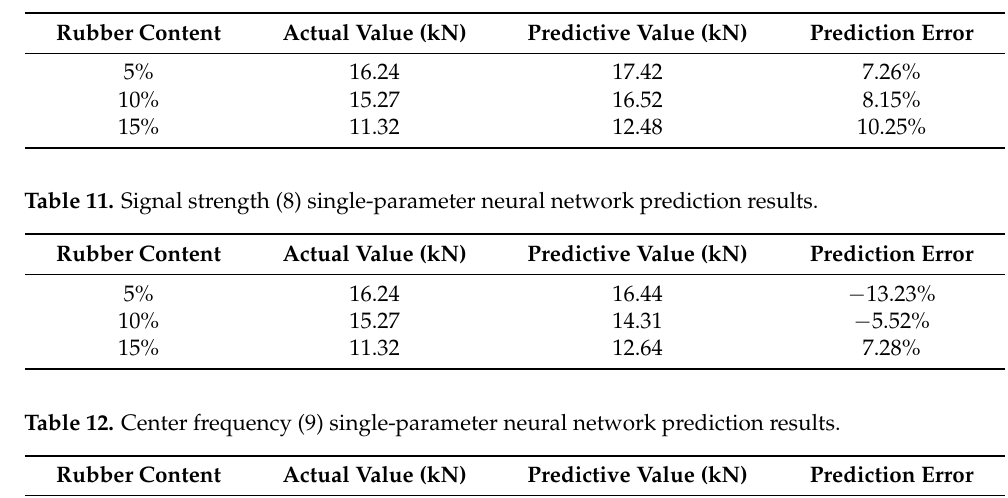
Table 10. ASL (7) single-parameter neural network prediction results.